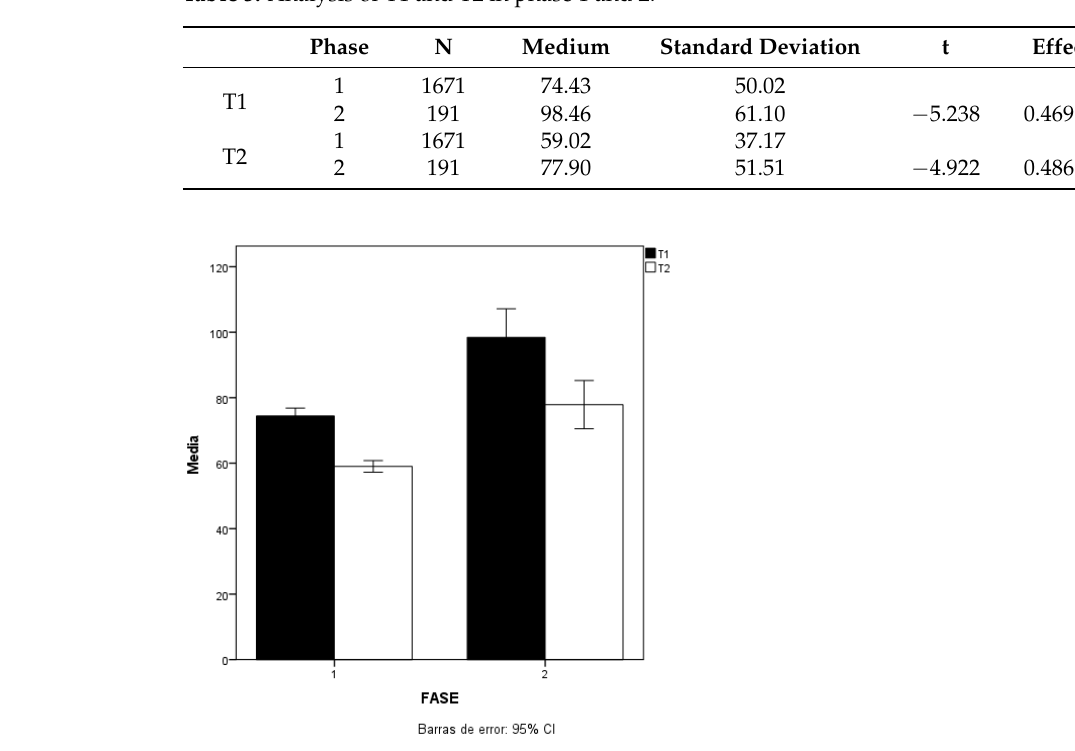
Table 3. Analysis of T1 and T2 in phase 1 and 2.